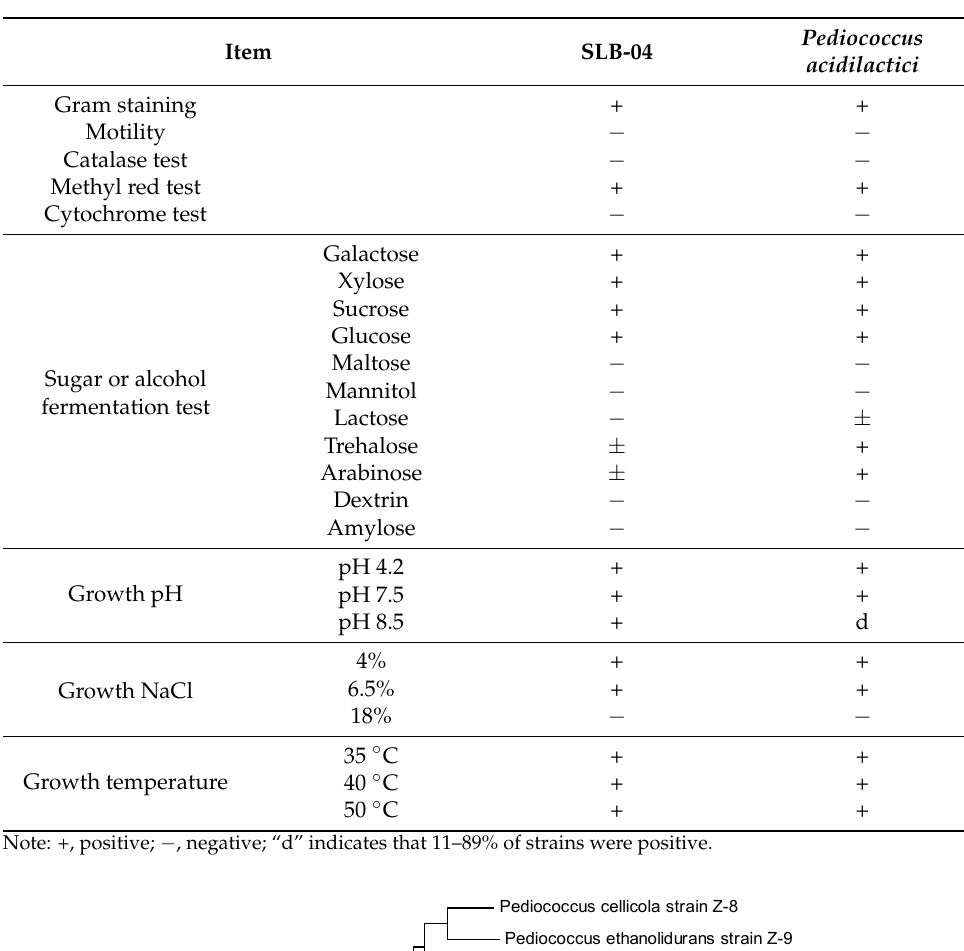
Table 5. Comparison of some physiological and biochemical test results for strain SLB-04 and Pediococcus acidilactici .